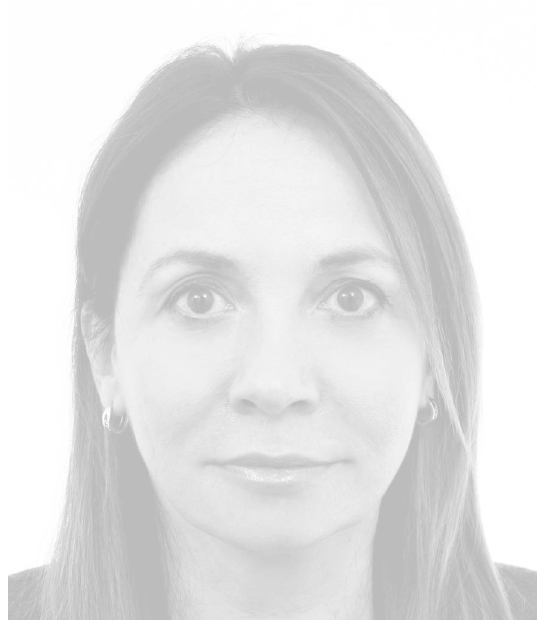
Figure 9. NIR graphic (1000